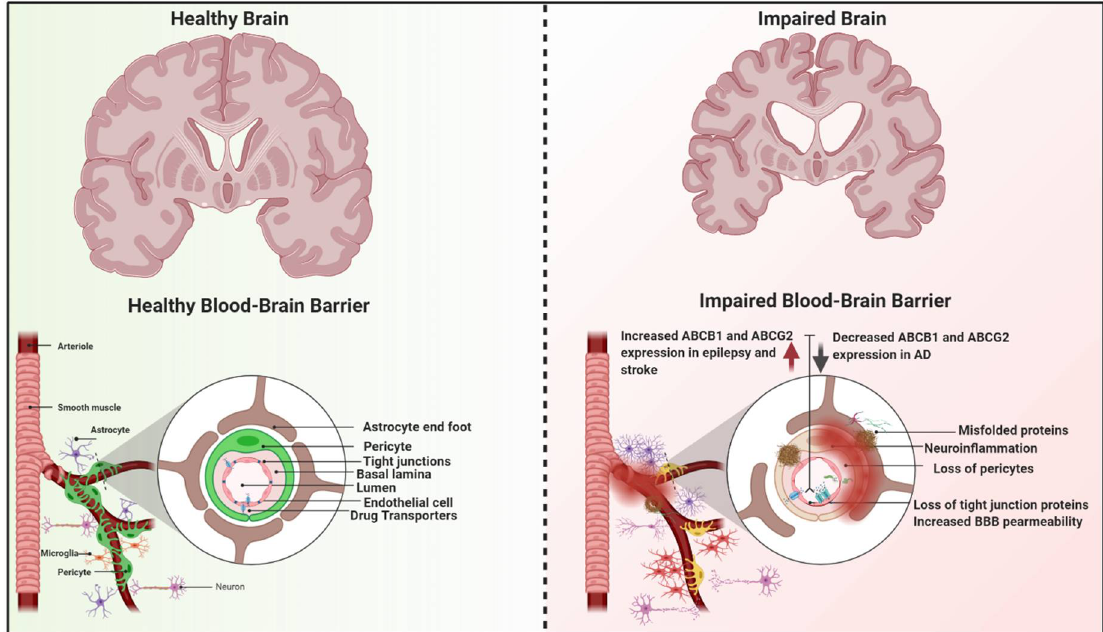
Figure 6. The blood–brain barrier (BBB) under healthy and diseased conditions. The BBB is formed by endothelial cells of the brain capillaries that are connected with tight junctions and supported by the neurovascular unit. Under neurological diseases and in aging, the BBB may undergo modulations affecting its permeability and integrity. Failure in BBB function may lead to a state of brain dyshomeostasis, neurodegeneration and brain atrophy. (Created with BioRender, accessed on 27 January 2021).